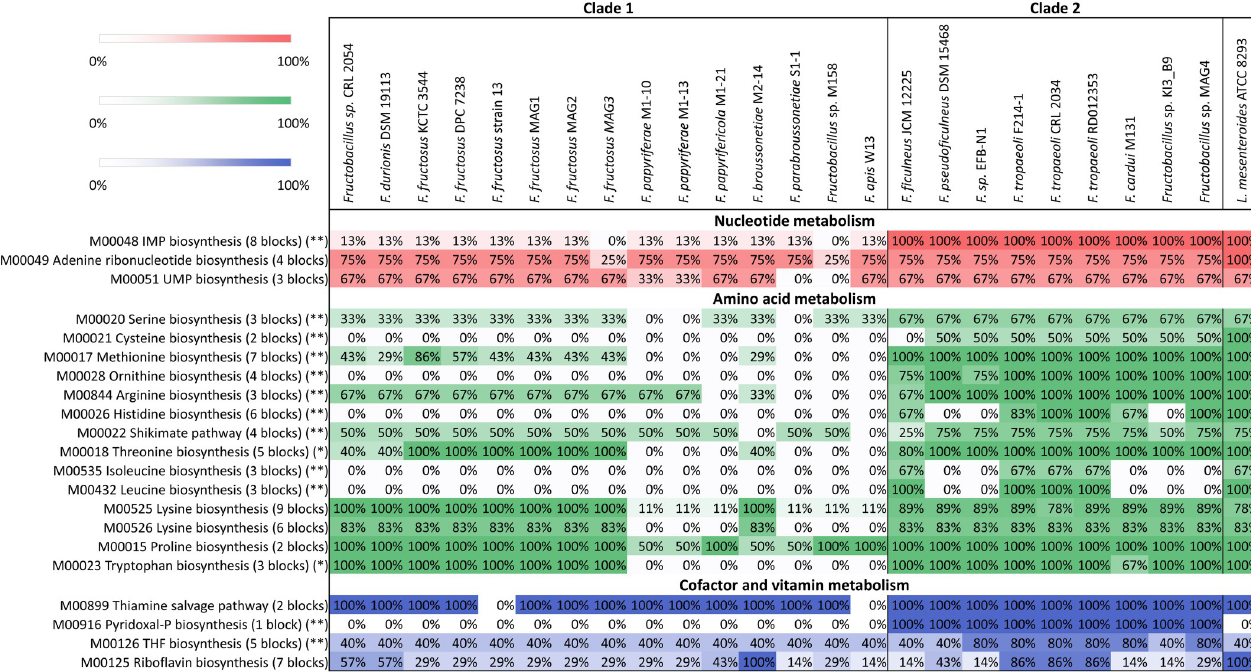
Fig 5. Pseudo-heatmap representing the level of completeness of KEGG metabolic modules in the studied Fructobacillus strains and L . mesenteroides ATCC 8293 T . Numbers in parentheses indicate the number of total blocks for each pathway, and percentages show the ratio between found blocks in each genome and total blocks for each metabolic module. One asterisk ( p < 0.05) or two asterisks ( p < 0.01) indicate modules with significant differences in the number of present blocks between both groups of strains (clades 1 and 2).